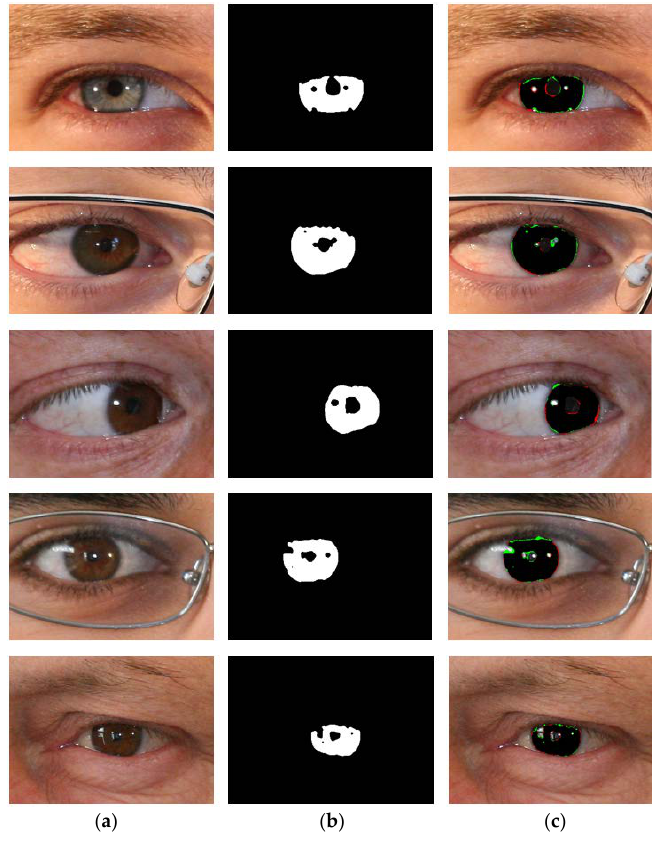
Figure 8. Examples of NICE-II good segmentation results obtained by IrisDenseNet. ( a ) Original image. ( b ) Ground-truth image. ( c ) Segmentation result obtained by IrisDenseNet (The false positive and negative errors are shown in green and red, respectively. The true positive case is shown in black).